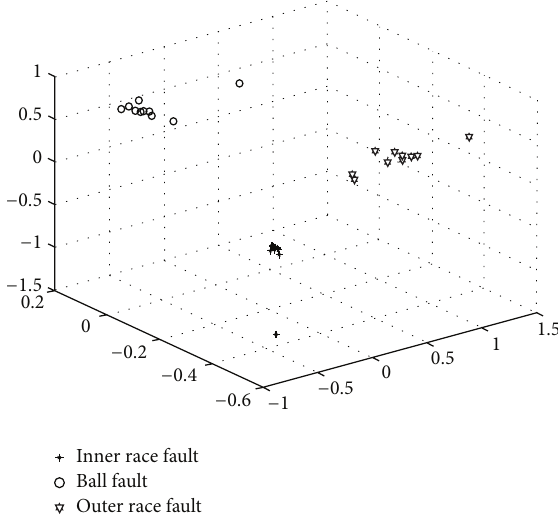
Figure 8: The result of the signal purified by optimized morpholog- ical filter and use of the LTSA to extract the original